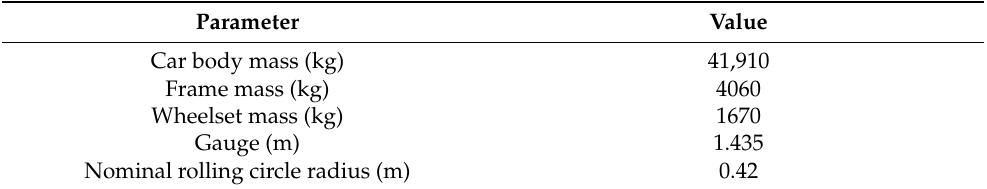
Table 2. Principal